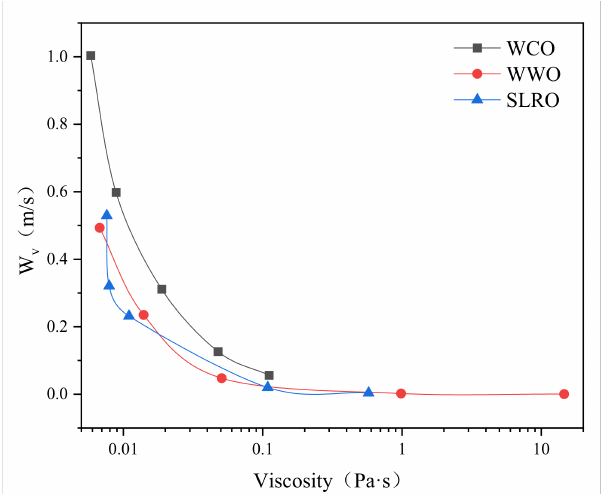
Figure 9. Effect of viscosity on W v